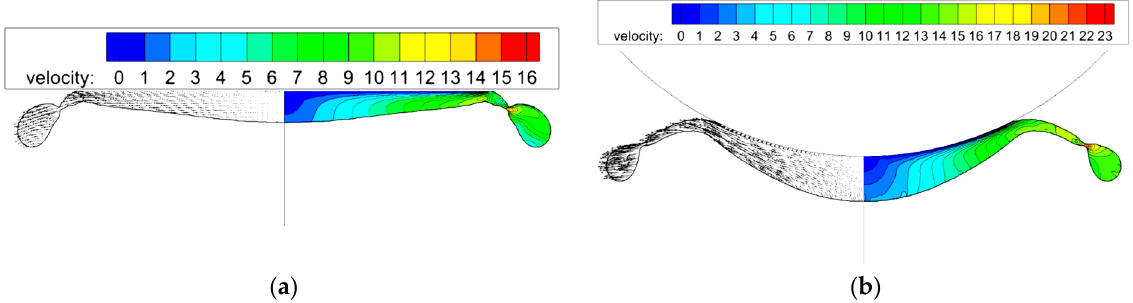
Figure 11. Velocity distribution: ( a ) droplet impacting flat wire; ( b ) droplet impacting circular wire. Figure 12 presents the dynamic evolution process of droplet impacting the flat wire and the circular wire at different initial velocities. At 2 μ s, the droplet spreading increases with the increase in the initial velocity, but the change of the initial velocity has little influence on the jet development for the flat wire. When the droplet impacts the circular wire, the larger the initial velocity, the larger the spreading degree of the droplet. It can be of the lifted lamella, that is, the larger the initial velocity, the narrower the lifted